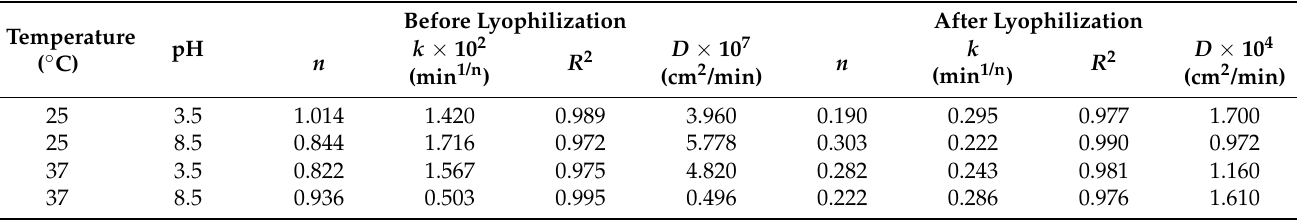
Table 3. Kinetic parameters of p(NIPAM-co-AA) hydrogel swelling before and after lyophilization at different pH values (3.5 and 8.5) and temperatures (25 and 37 ◦